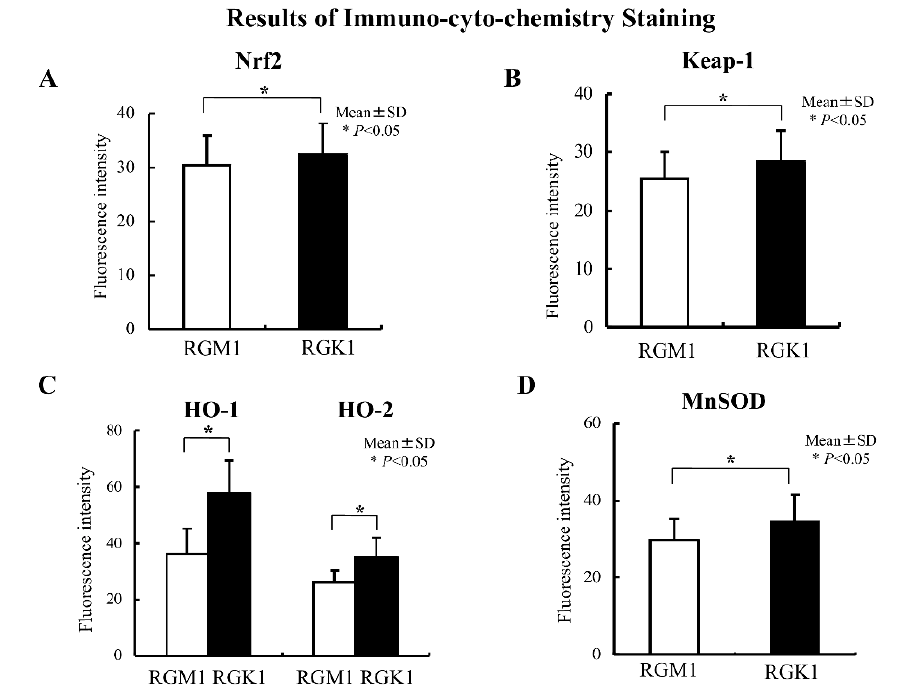
Figure 3. Results of immunocytochemistry staining. Immunohistochemical staining with an anti-Nrf2 antibody in RGM1 and RGK1 cell lines was performed. ( A ) The fluorescence intensity was significantly higher in RGK1 cells compared with that in RGM1 cells. Bar: mean ± S.D.; t -test. * p < 0.05. ( B ) Immunohistochemical staining with an anti-Keap1 antibody in RGM1 and RGK1 cell lines was performed. The fluorescence intensity was significantly higher in RGK1 cells compared with that in RGM1 cells. Bar: mean ± S.D.; t -test. * p < 0.05. ( C ) Immunohistochemical staining with anti-HO-1 and anti-HO-2 antibodies in RGM1 and RGK1 cell lines was performed. The fluorescence intensity for both HO-1 and HO-2 was significantly higher in RGK1 cells compared with that in RGM1 cells. Bar: mean ± S.D.; t -test. * p < 0.05. ( D ) Immunohistochemical staining with an anti-MnSOD antibody in RGM1 and RGK1 cell lines was performed. The fluorescence intensity was significantly higher in RGK1 cells compared with that in RGM1 cells. Bar: mean ± S.D.; t -test. * p < 0.05.